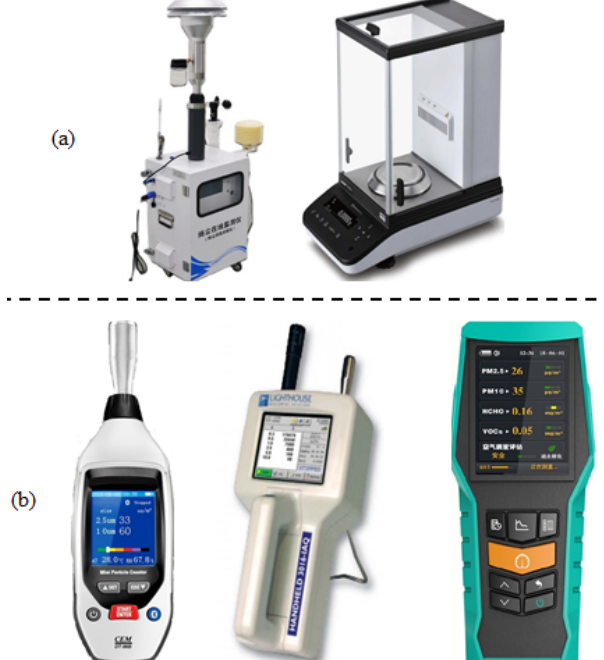
Figure 1. Examples of some PM 2.5 concentration monitoring equipment. ( a ) The professional PM 2.5 monitoring devices based on the β -ray absorption method and the tapered element oscil- lating microbalance method. ( b ) The household PM 2.5 monitoring devices based on the laser and infrared principles.